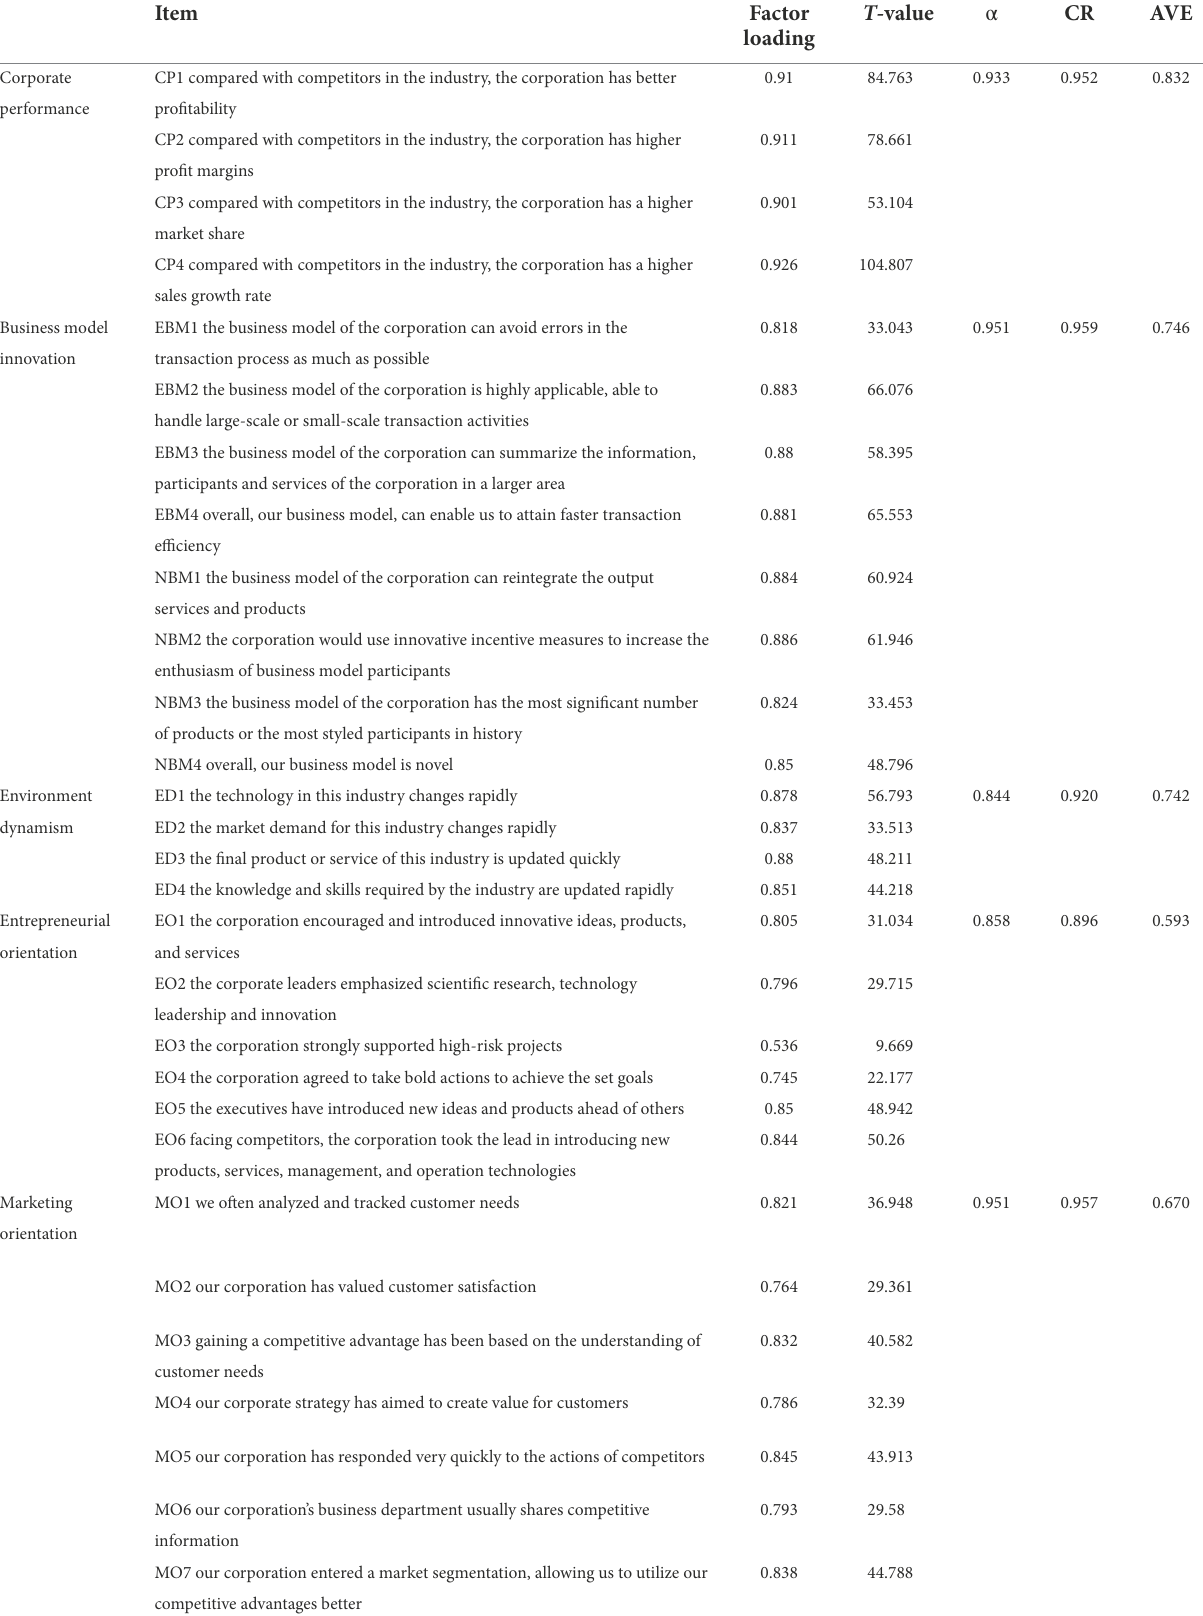
TABLE 2 The measurement model results. Item Factor